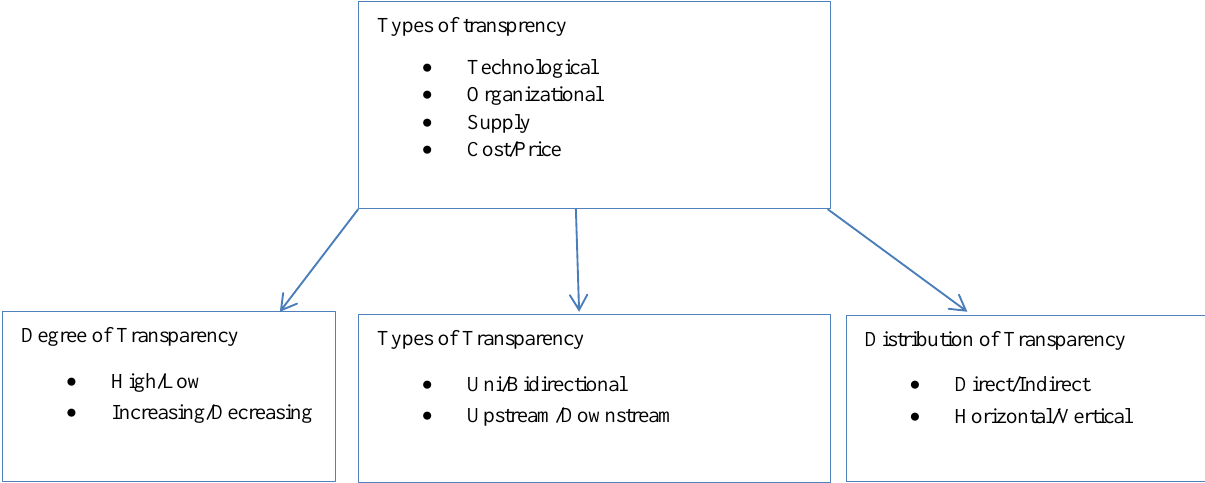
Fig. 1: Transparency; Source: Jens and Björn (2007). . Table 1: Dimensions of